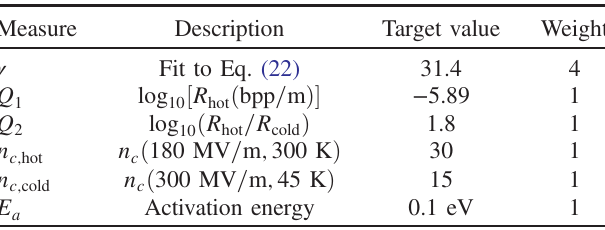
Fig. 8(b) and the single measurement at 45 K must be fitted with the same β since they were both measured in the same structure, or, equivalently, the electric field must be scaled identically in both sets. Scaling the fields, so that the data of the leftmost set matches the fit of the reference set, yields a scaled field of 300 MV = m for the measurement at 45 K. Comparing the BDRs of this measurement and the refer- =R ence set, we have log 10 ð R is the Þ ≈ 1 . 8 , where R hot cold cold BDR at E ¼ 300 MV = m and T ¼ 45